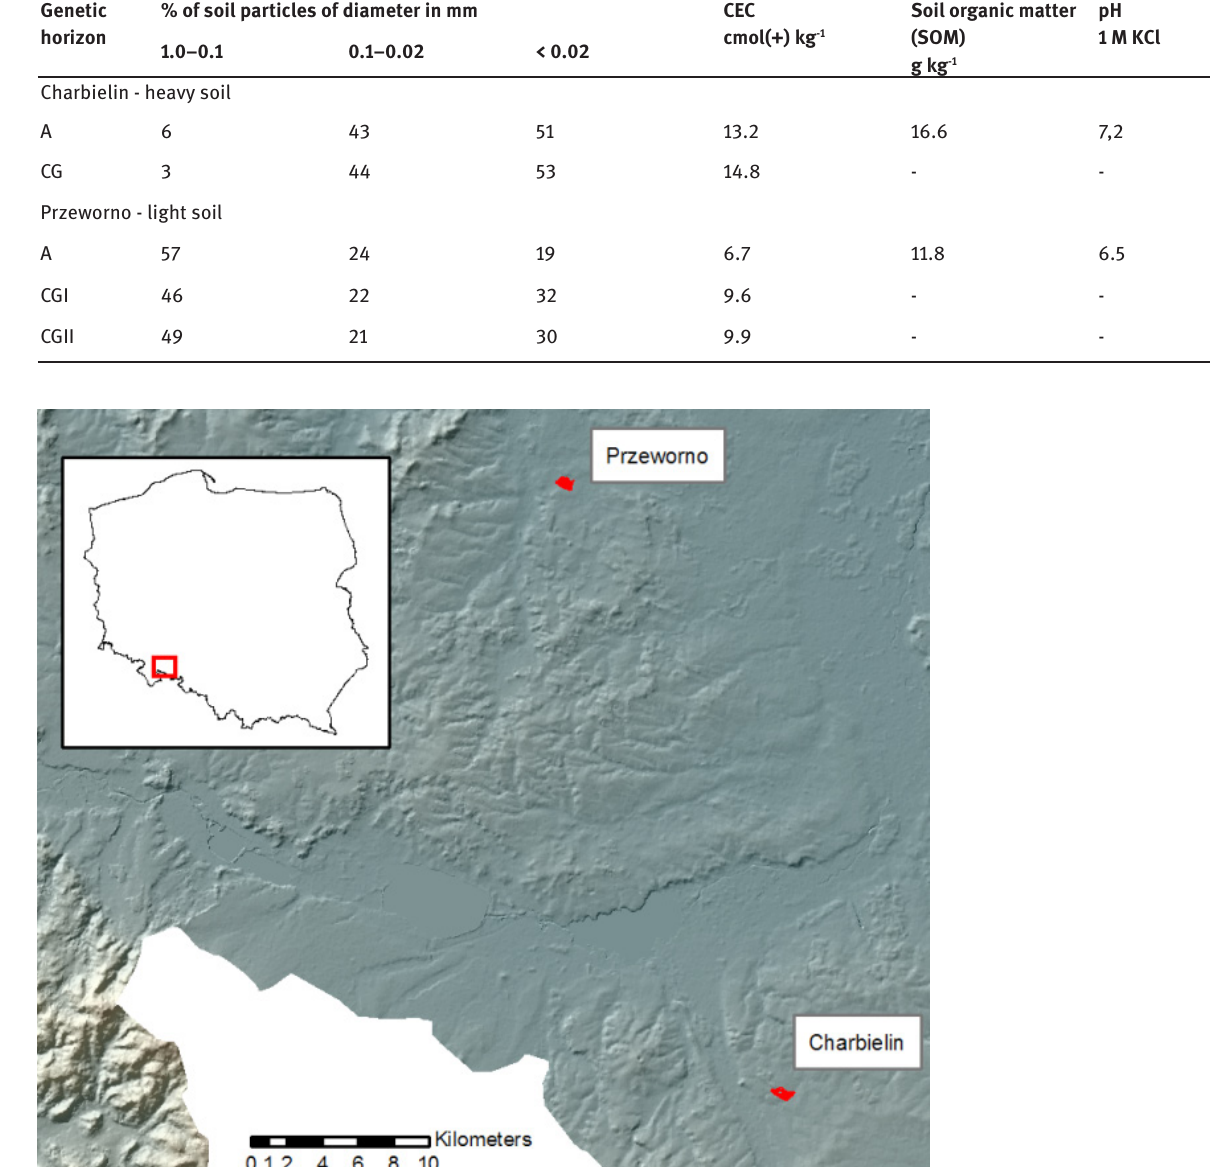
Figure 1: Location of the experimental fields (Produced using Copernicus data and information funded by the European Union - EU-DEM